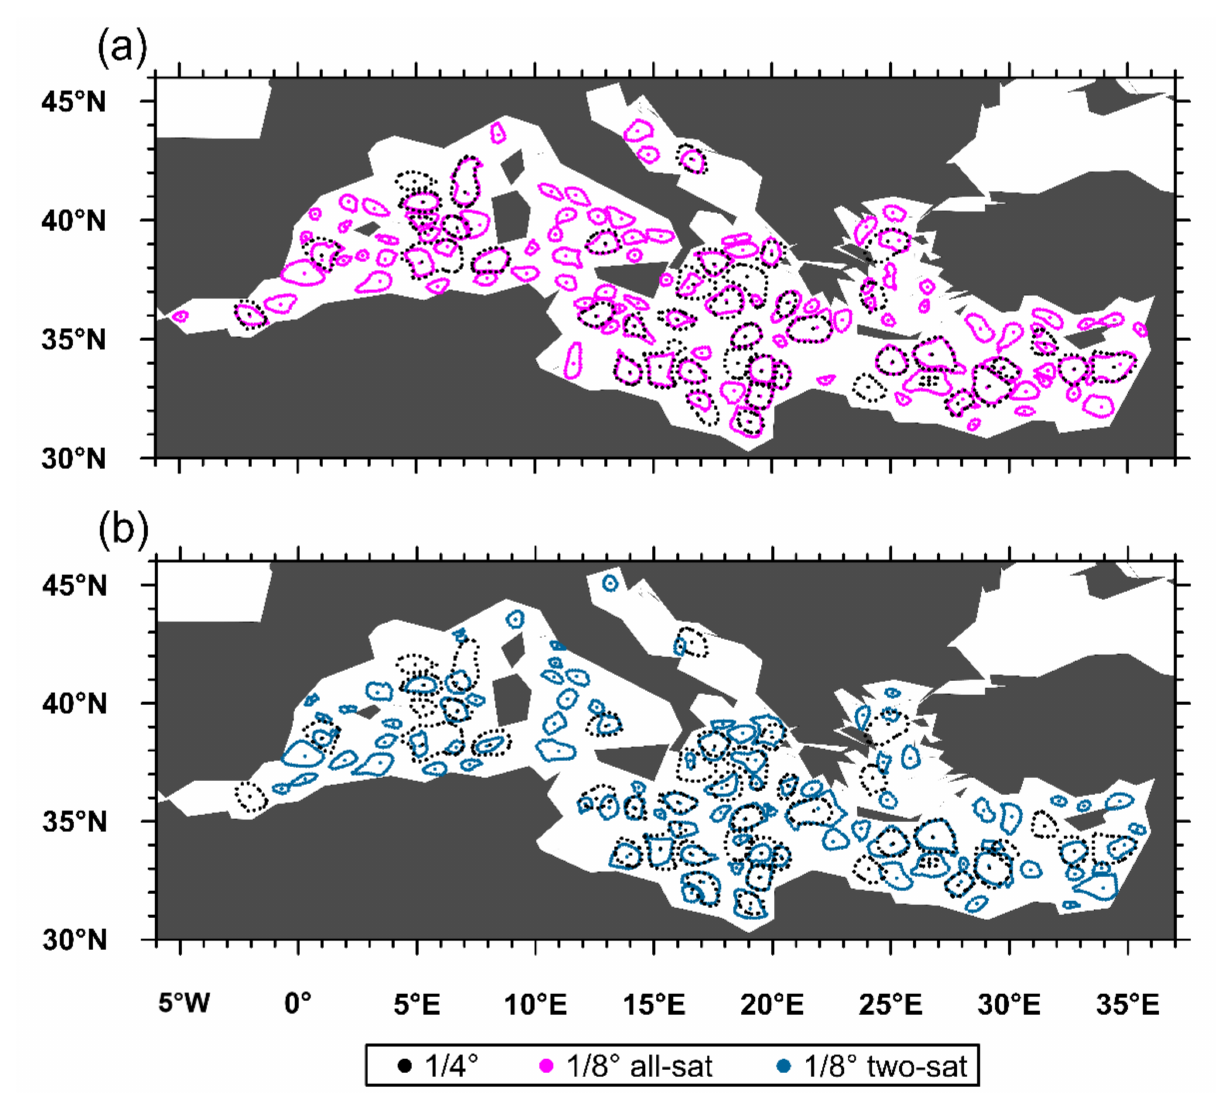
Figure 2. Overlay maps of eddy identification with two spatial resolutions and data types in the Mediterranean Sea: ( a ) 1/4 ◦ and 1/8 ◦ all-sat; ( b ) 1/4 ◦ and 1/8 ◦ two-sat. The black dots represent eddy effect contours identified using the 1/4 ◦ data, and the magenta (desert blue) dots represent eddy effect contours identified using the 1/8 ◦ all-sat (two-sat)